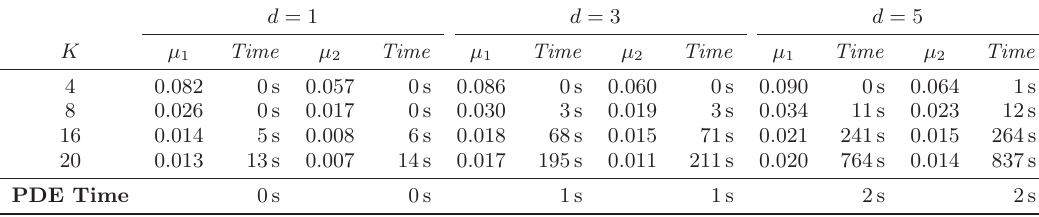
Table 1: Maximum absolute error between the ODE and PDE estimates of species S 1 at time 0 . 2 across the discrete mesh, for diffusion coefficients μ 1 = 0 . 10 and μ 2 = 0 . 15 .